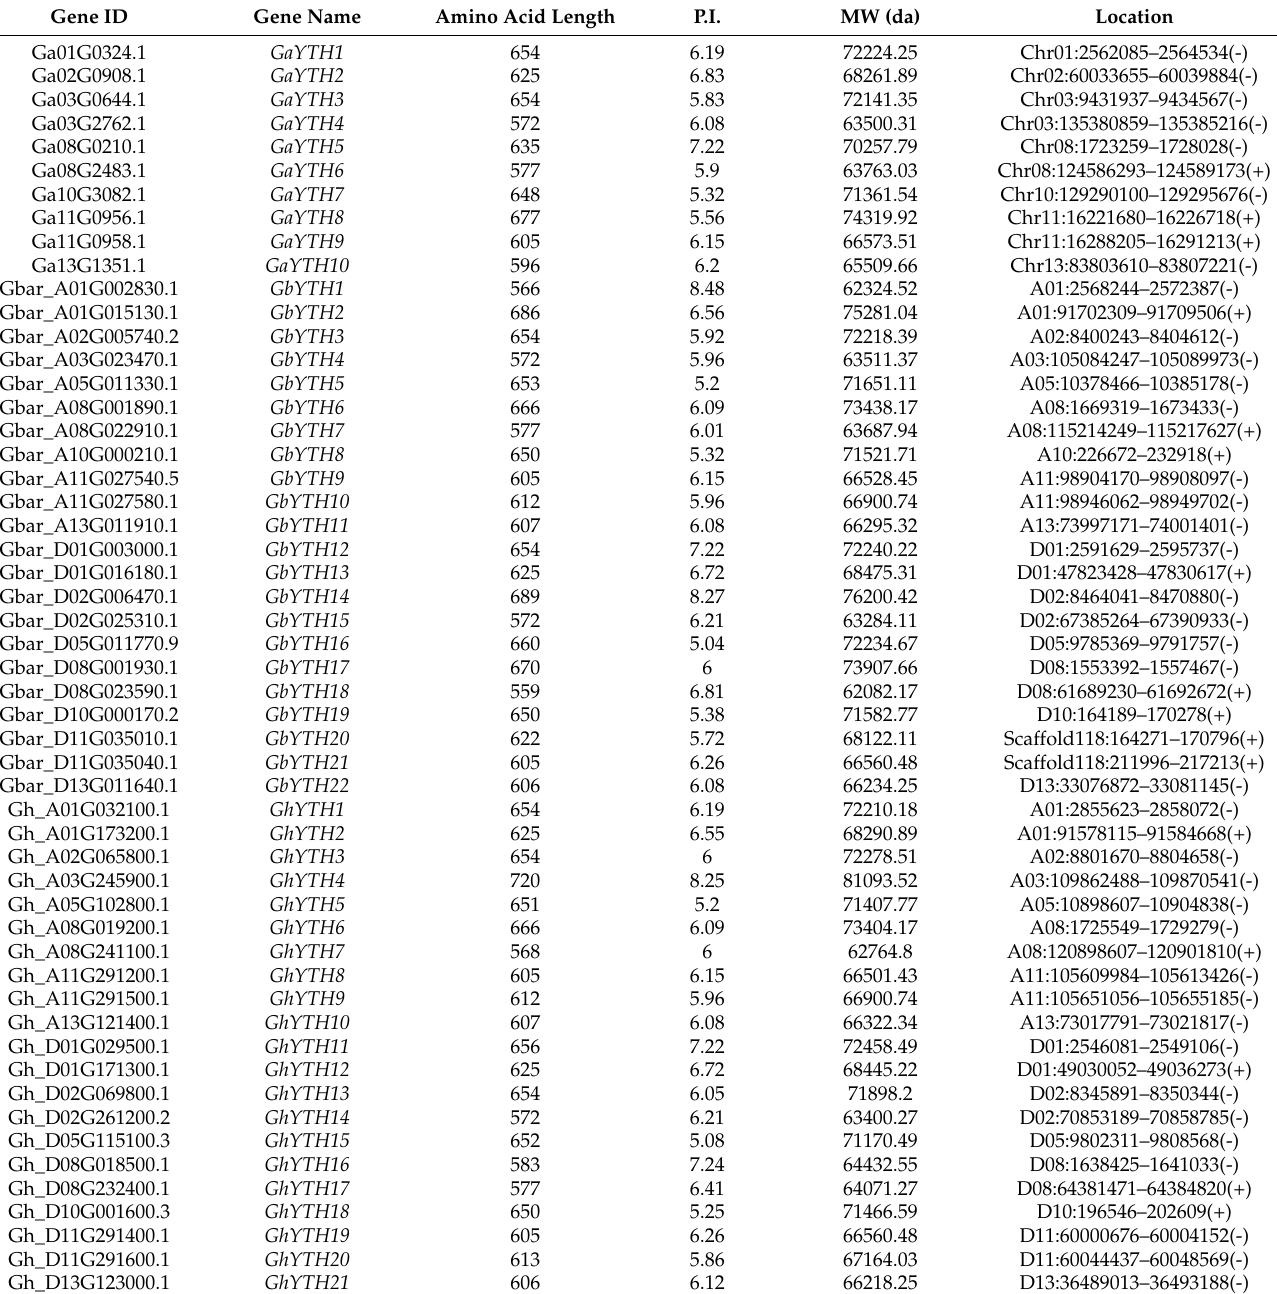
Table 1. Characteristics of YTH genes and their encoded proteins in